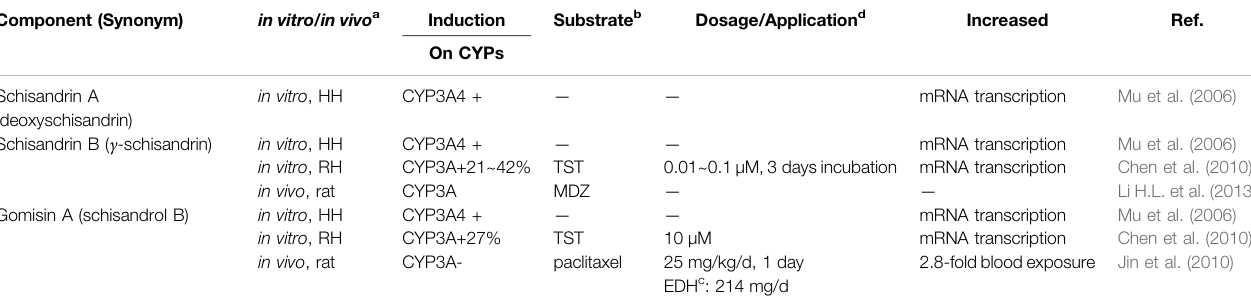
TABLE 4 | Induction of CYP3A activity by the major schisandra